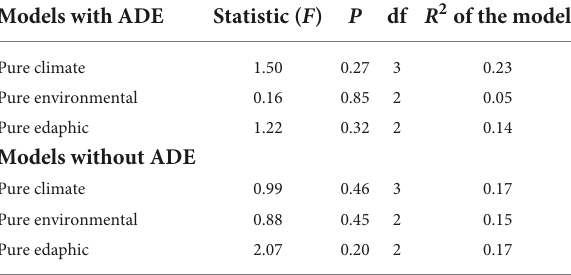
TABLE 3 Models with and without ADE to estimate soil